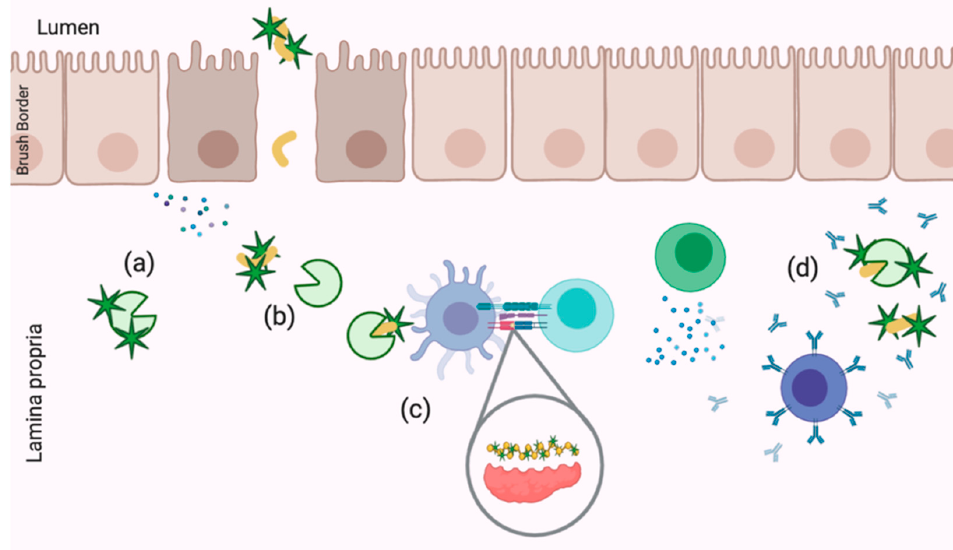
Figure 3. Demonstrated mechanisms of celiac disease pathogenesis disruption by dietary polyphenols including ( a ) TG2 inhibition, ( b ) TG2 epitope masking, ( c ) antigen presentation disruption and ( d ) anti-gliadin IgA epitope masking.